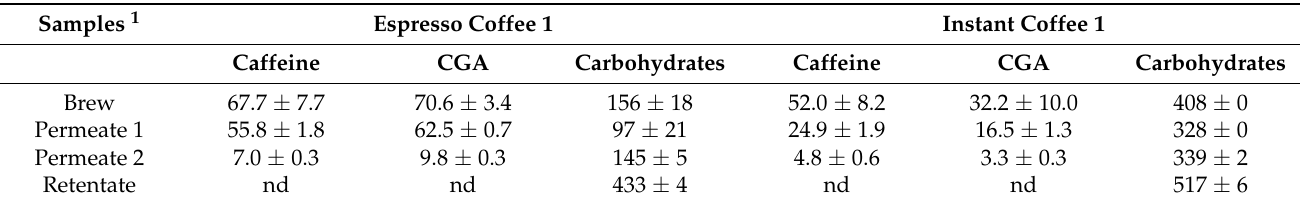
Table 3. Quantification (mg/g) of caffeine, free chlorogenic acids (CGA), and carbohydrates content of espresso coffee 1 and instant coffee 1 brews, and derived ultrafiltered Permeates 1 and 2, and Retentate. Samples